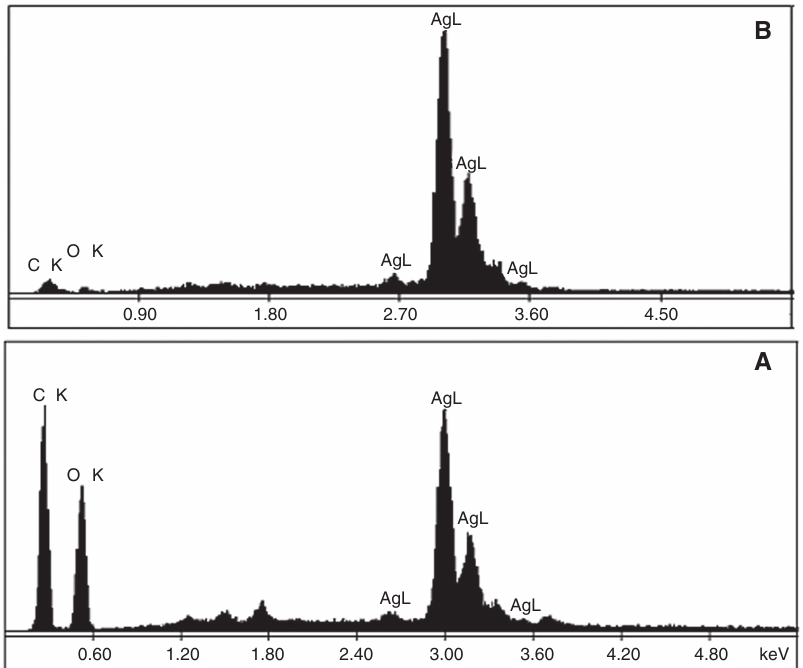
Figure 5 Scanning electron microscopy (SEM) of silver layers of the nanocomposite films.